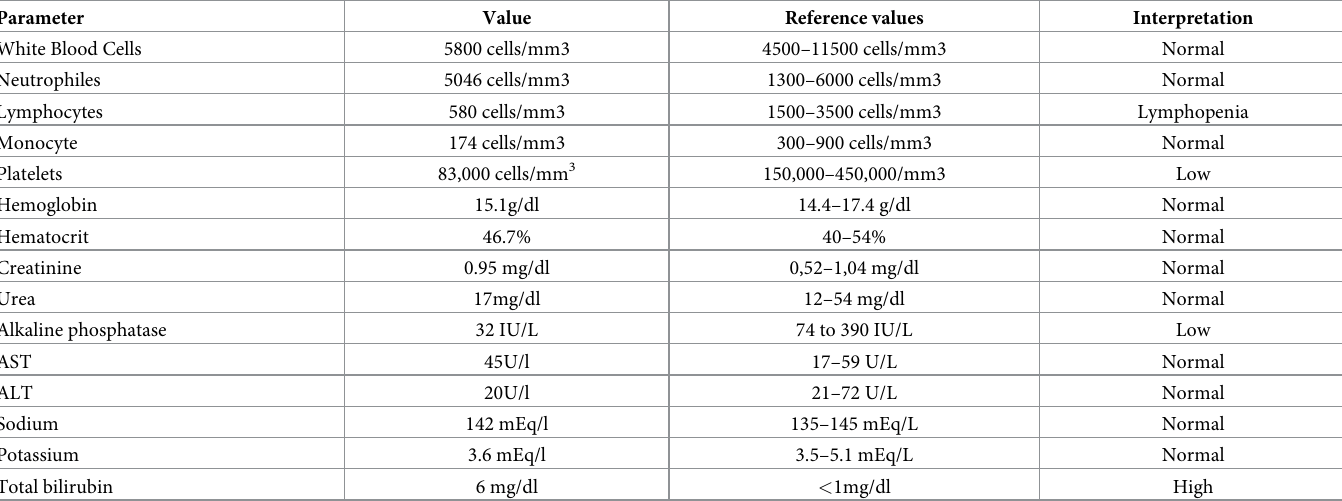
Table 1. Laboratory findings in a Hantavirus Pulmonary Syndrome patient at day 2 after the onset of